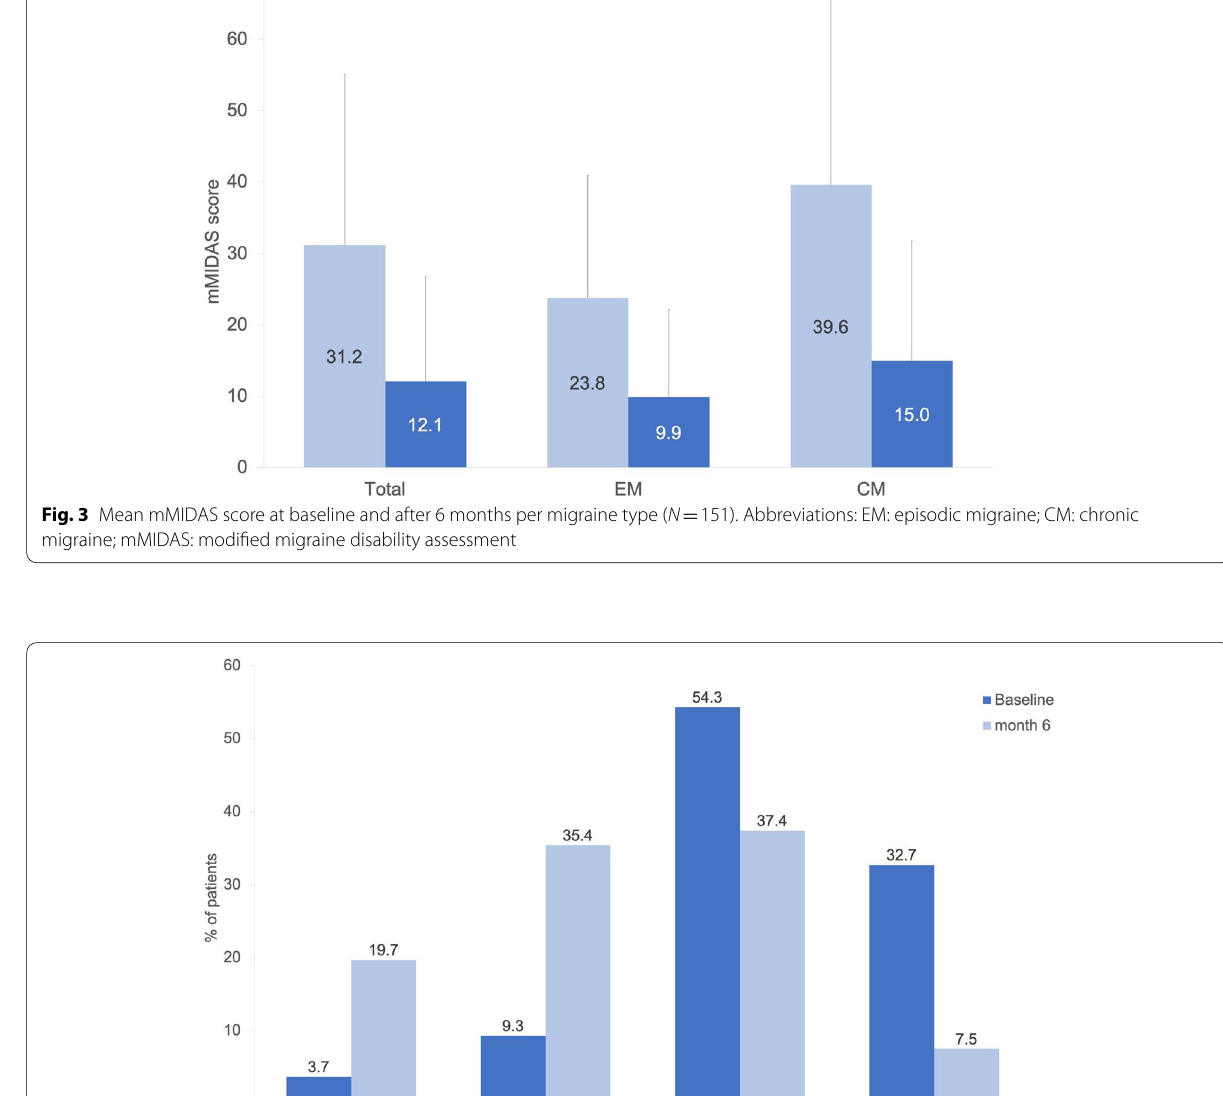
Fig. 4 IMPAC grades at baseline ( N